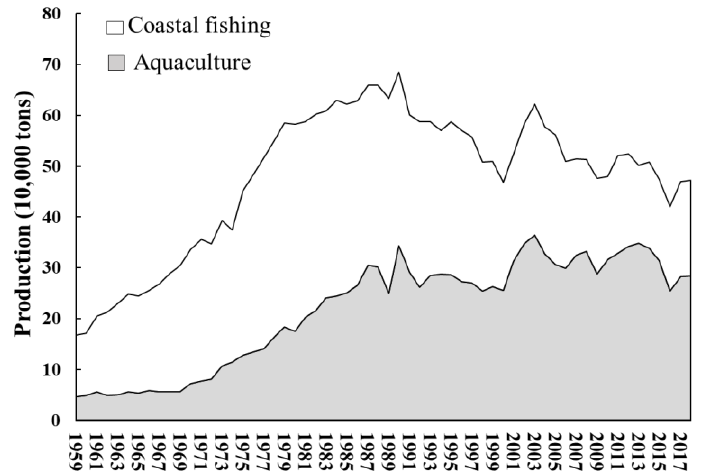
Figure 1. Coastal fishing and aquaculture production in Taiwan, 1953–2018. The data were obtained from the Fishery Agency, accessed on 25 May 2021.